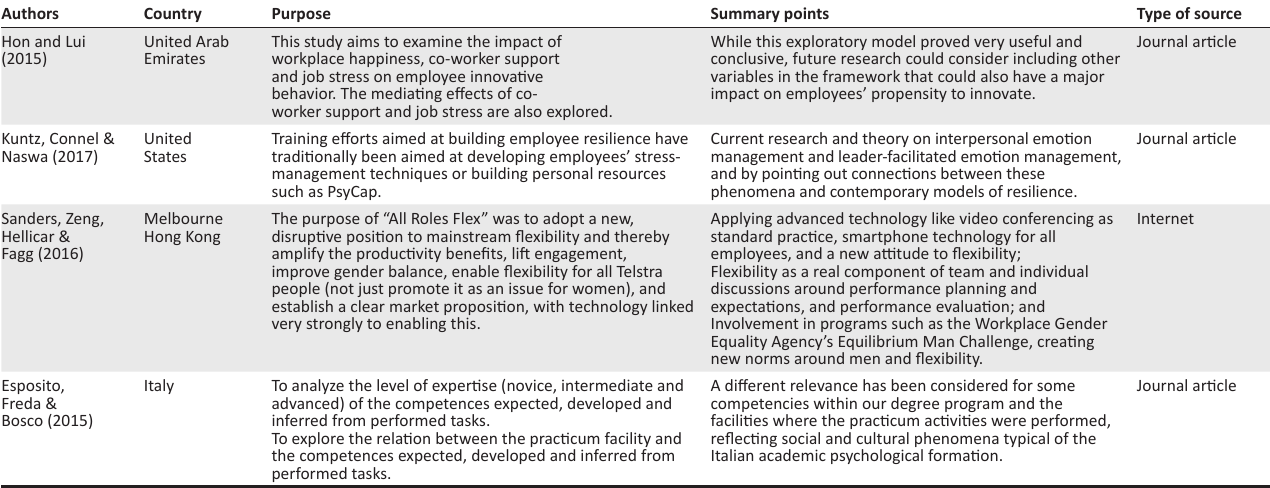
TABLE 1: Summary